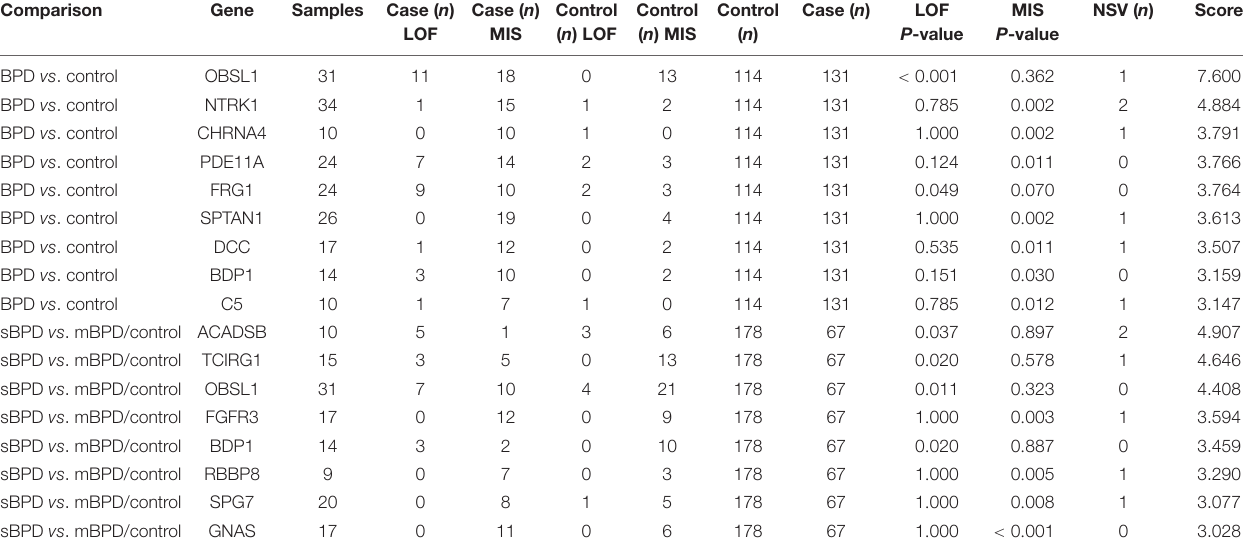
TABLE 2 | Genes with a significant burden for LOF/MIS